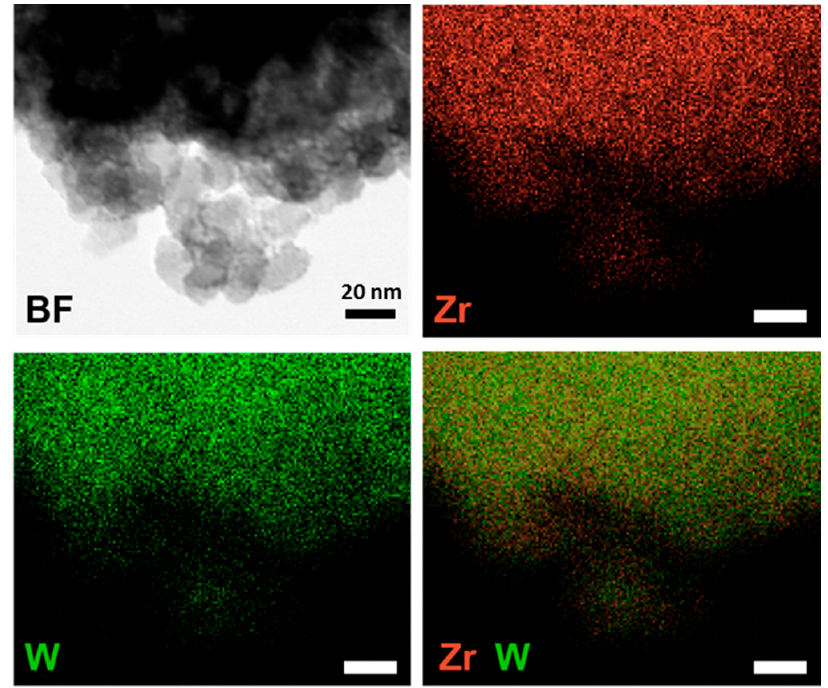
Figure 2. BF (Bright-Field) scanning transmission electron microscopy (STEM) image and energy-dispersive spectroscopy (EDS) elemental mapping of the 40W-Zr sample. The scale bars represent 20 nm.